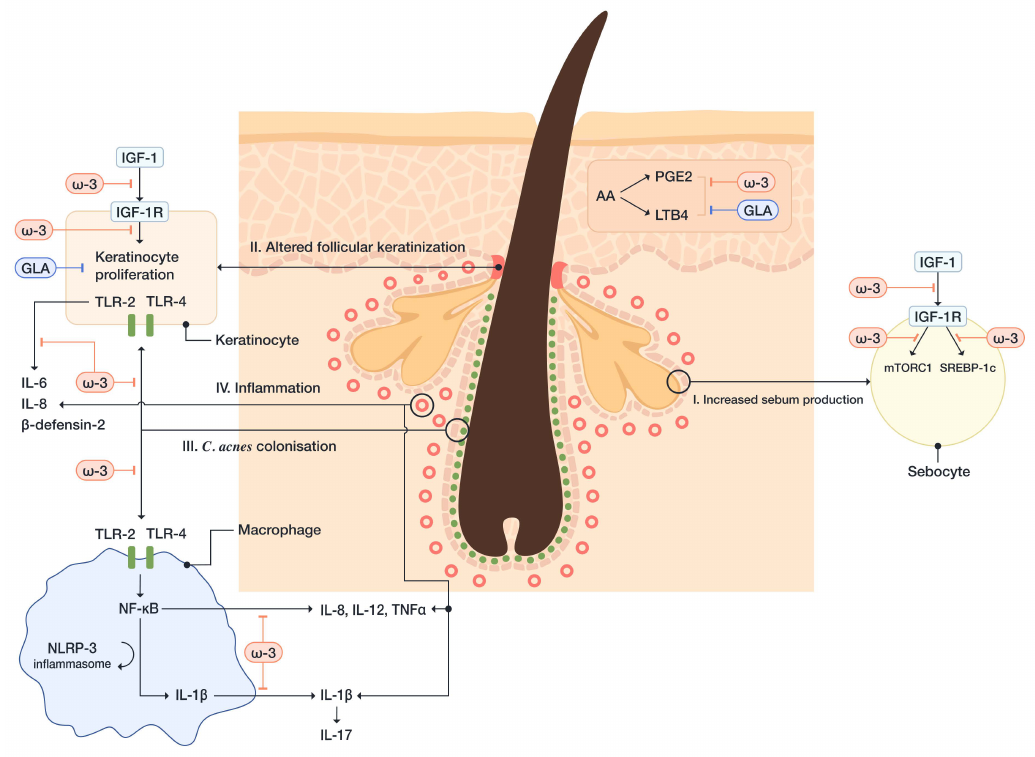
Figure 2. Schematic presentation of the mechanisms via which essential fatty acid influence the four main pathogenetic factors in acne, including I. increased sebum production, II. altered